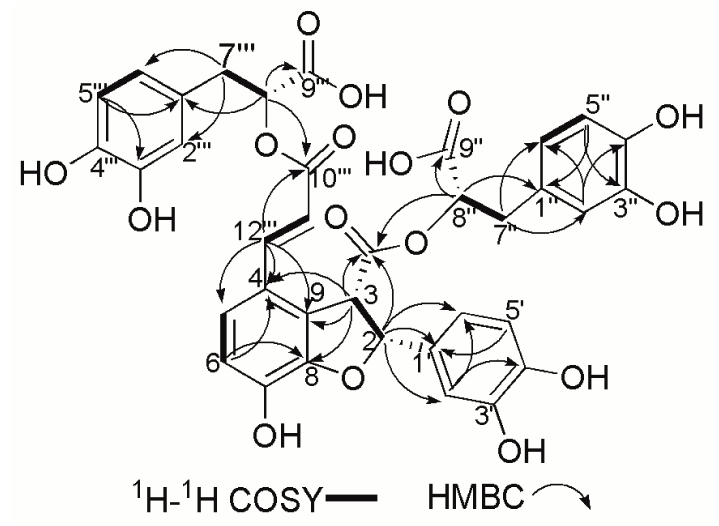
Figure 2. Key 1 H- 1 H COSY and HMBC correlations (H → C) in TSL 1.